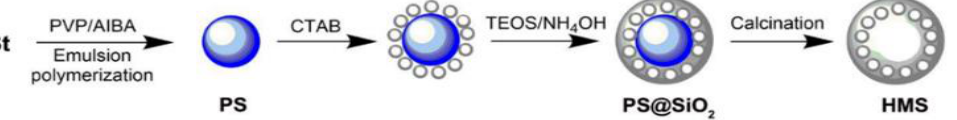
Figure 16. Schematic diagram of the synthesis of hollow mesoporous silica spheres (HMSs) using the surfactant and PS [65].